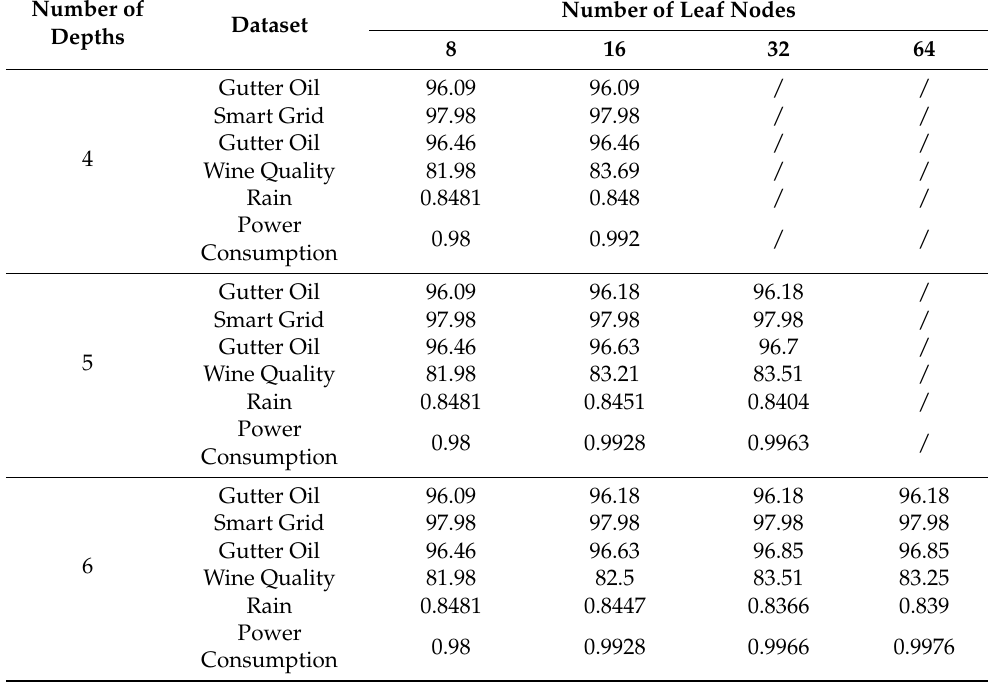
Table A3. The score for different DT